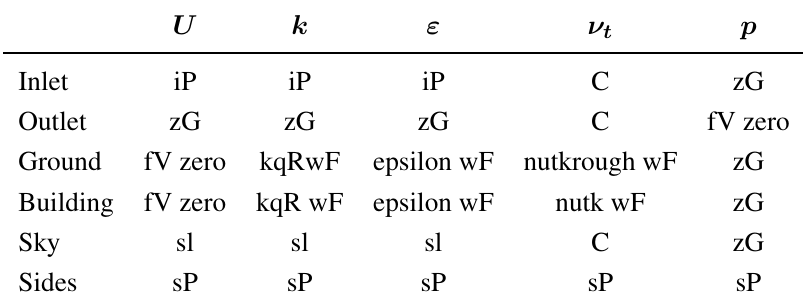
Figure 1. Diagram of the wind-tunnel geometry and the axes V1–V3 for the validation of the results. All lengths are in meters. Table 1. Boundary conditions imposed at each boundary of the domain. Nomenclature: C = calculated; fV = fixed value; iP = inlet profile; sl = slip; sP = symmetry plane; wF = wall function; zG = zero